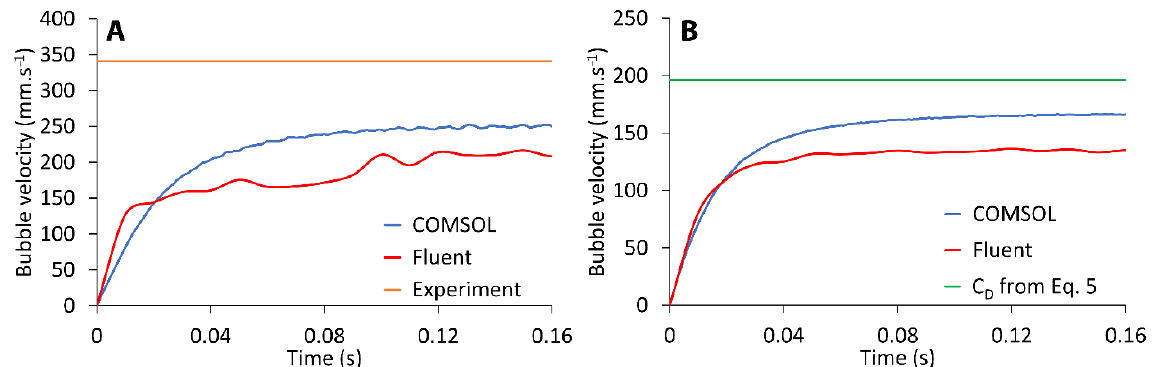
Figure 4. ( A ) Time-dependent velocity of a 1.5 mm bubble rising in pure water, compared to a steady-state experimental value. ( B ) Time-dependent velocity of a 1.5 mm bubble rising in pure propanol, compared to steady-state theoretical value computed using Moore expression (Equation (5)) for deformed bubble.